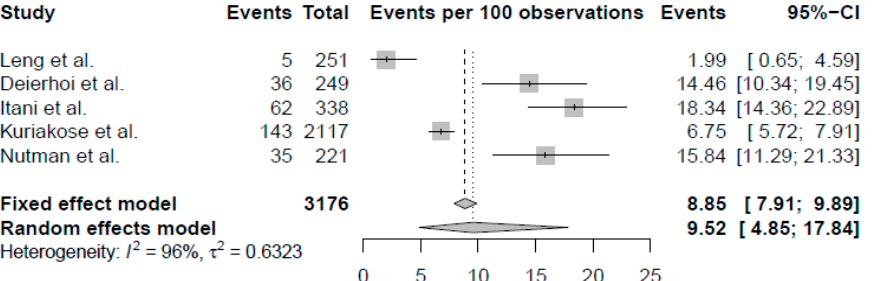
Figure 1. Meta-analysis of the proportion of surgical site infections following prophylaxis with ertapenem in elective colorectal surgery procedures.